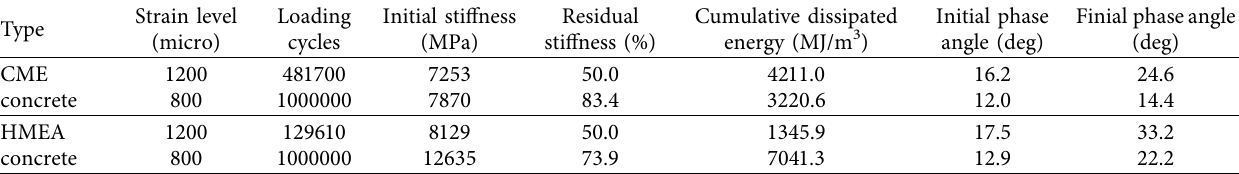
Table 16: The four-point beam fatigue behavior of CME concrete and HMEA